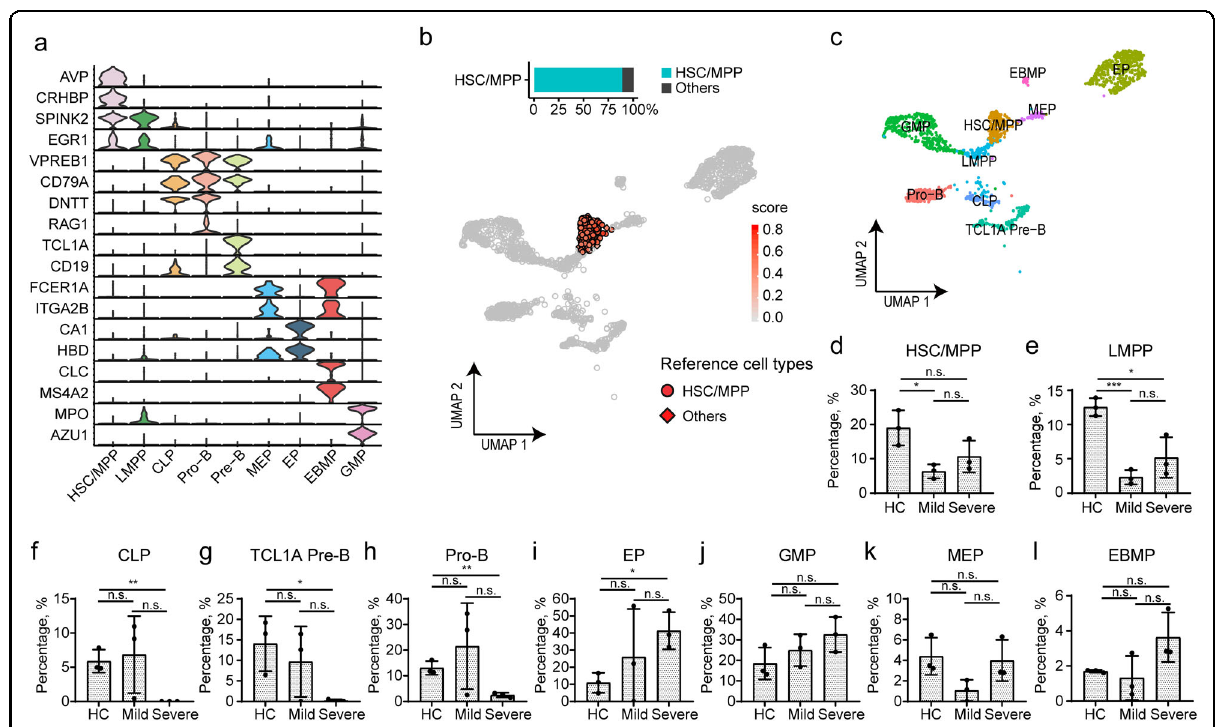
Fig. 2 Annotation of HSPCs by cell-speci fi c markers and immunophenotype-based reference dataset. a Violin plots show the expression of cell-speci fi c markers for nine HSPC clusters. b Label transfer of HSC/MPP population according to an immunophenotype-based reference dataset. c UMAP displays the distribution of nine cell clusters of HSPCs. d – l The proportion of nine clusters in HSPCs from HC and COVID-19 patients. P values for pairwise comparisons were calculated, unpaired two-sided Student ’ s t- test, * P < 0.05, ** P < 0.01, *** P < 0.001, n.s., not signi fi